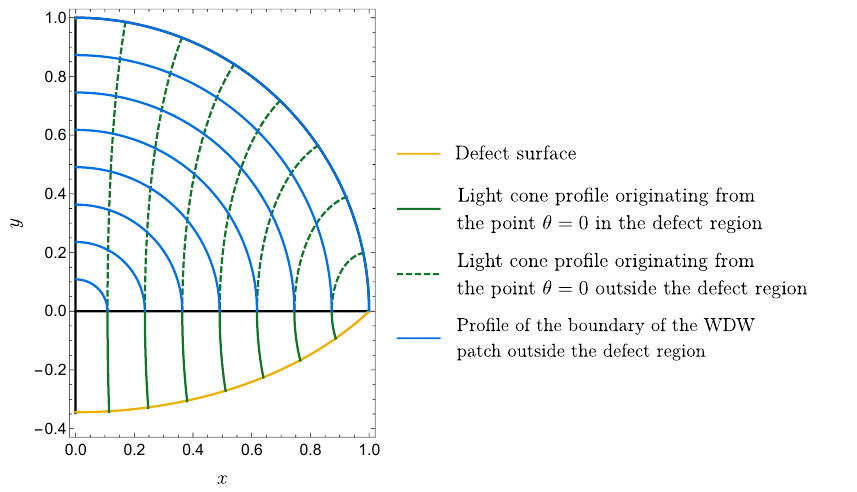
Figure 4. Cross section of the boundary of the WDW patch for di(cid:11)erent times t denoted by the green and blue lines inside and outside the defect region respectively. In the defect region the boundary of the WDW patch is (cid:12)xed by the light cone emanating from the boundary at (cid:18) = 0, indicated by solid green curves, and it meets the lightcone surface coming from (cid:18) = (cid:25) along a ridge at (cid:18) = (cid:25)= 2 (and t = (cid:25)= 2). The rest of the boundary of the WDW patch is the conical region (cid:12)xed (cid:0) by straight infalling light rays coming from di(cid:11)erent boundary points along lines of constant (cid:18) and its cross section for di(cid:11)erent times t is indicated by the blue circular arcs. The plot corresponds to a defect parameter of y (cid:3) = 0 : 6, see eq. (2.3), and is presented using the x and y coordinates de(cid:12)ned in eq.